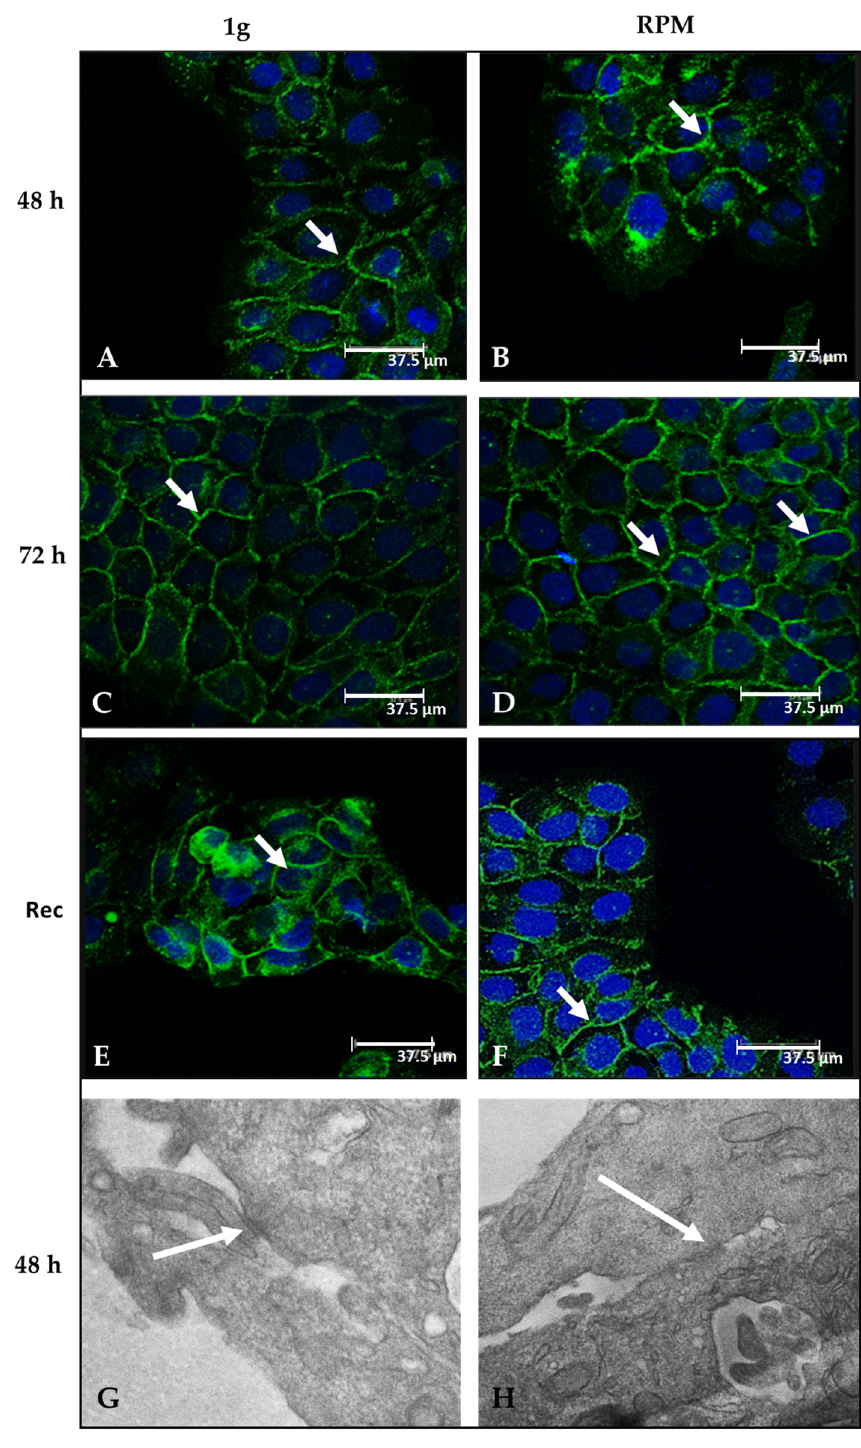
Figure 3. Representative confocal images of E-cadherin distribution in 1g ( A , C ) and RPM cultured cells for 48 and 72 h ( B , D ); ( E ) Control condition at 1g for 48 h; ( F ) recovery conditions: HaCaT cells were placed in RPM for 24 h and then transferred into a normal gravitational field for further 24 h. Under these conditions, E-cadherin fluorescence is again appreciable within the cell–cell contact area with a similar distribution pattern to the 1g condition (arrows). Scale bars 37.5 µm. ( G ) H representative TEM images of cells cultured for 48 hours at 1g ( G ) and in RPM condition ( H ). Arrows indicate cell–cell contact. Magnification 10,000×.